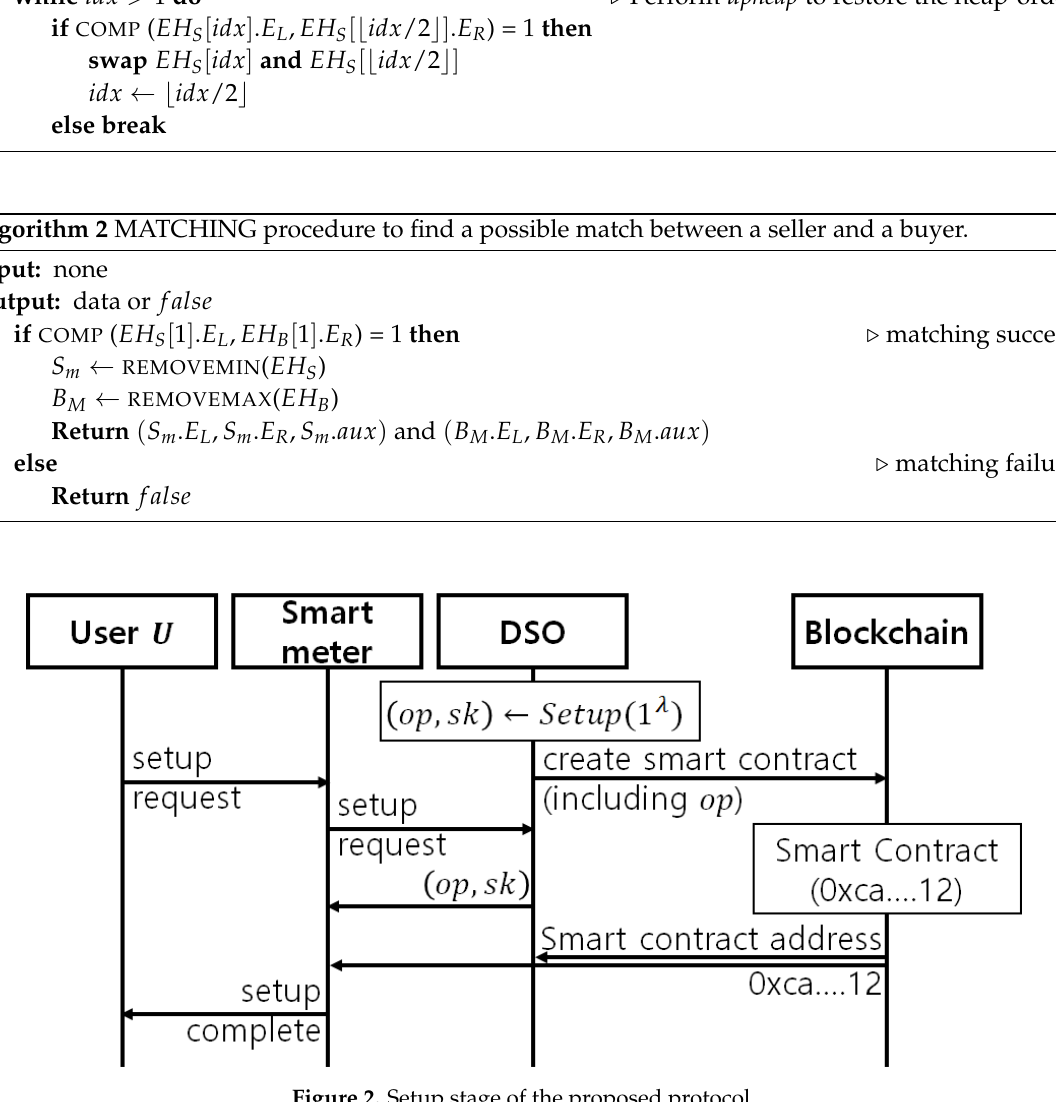
Figure 2. Setup stage of the proposed